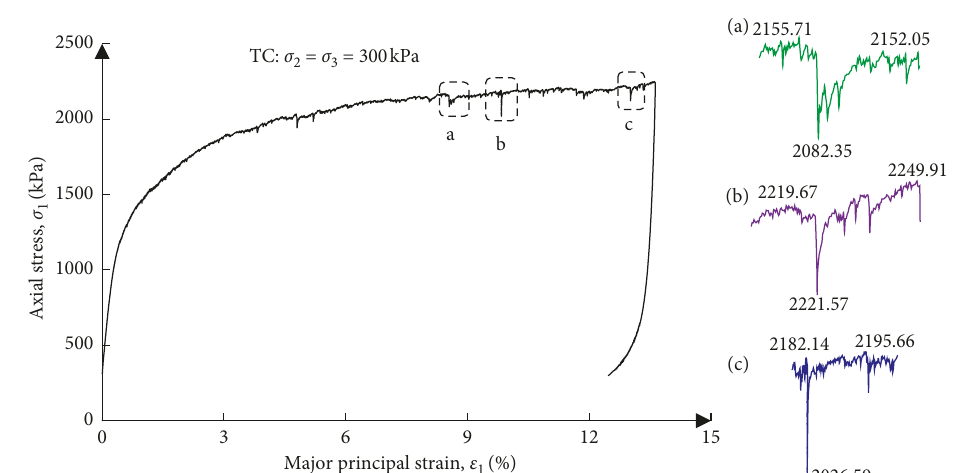
Figure 9: Fluctuation caused by particle breakage on the test